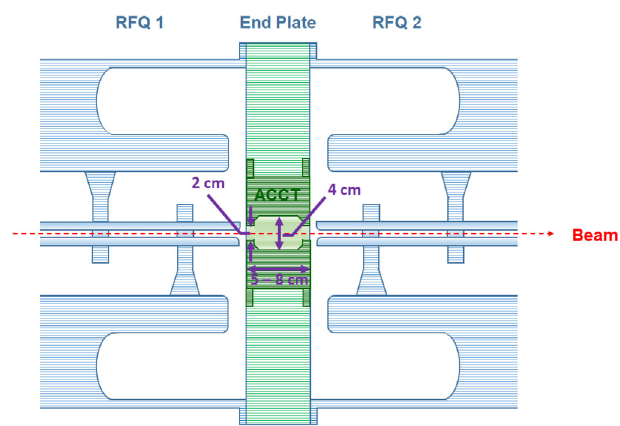
FIG. 9. Schematic plot for the connection of two RFQs by an rf shielding wall (the distance between two sets of electrodes excluding the rf shielding wall is 2.1 cm).